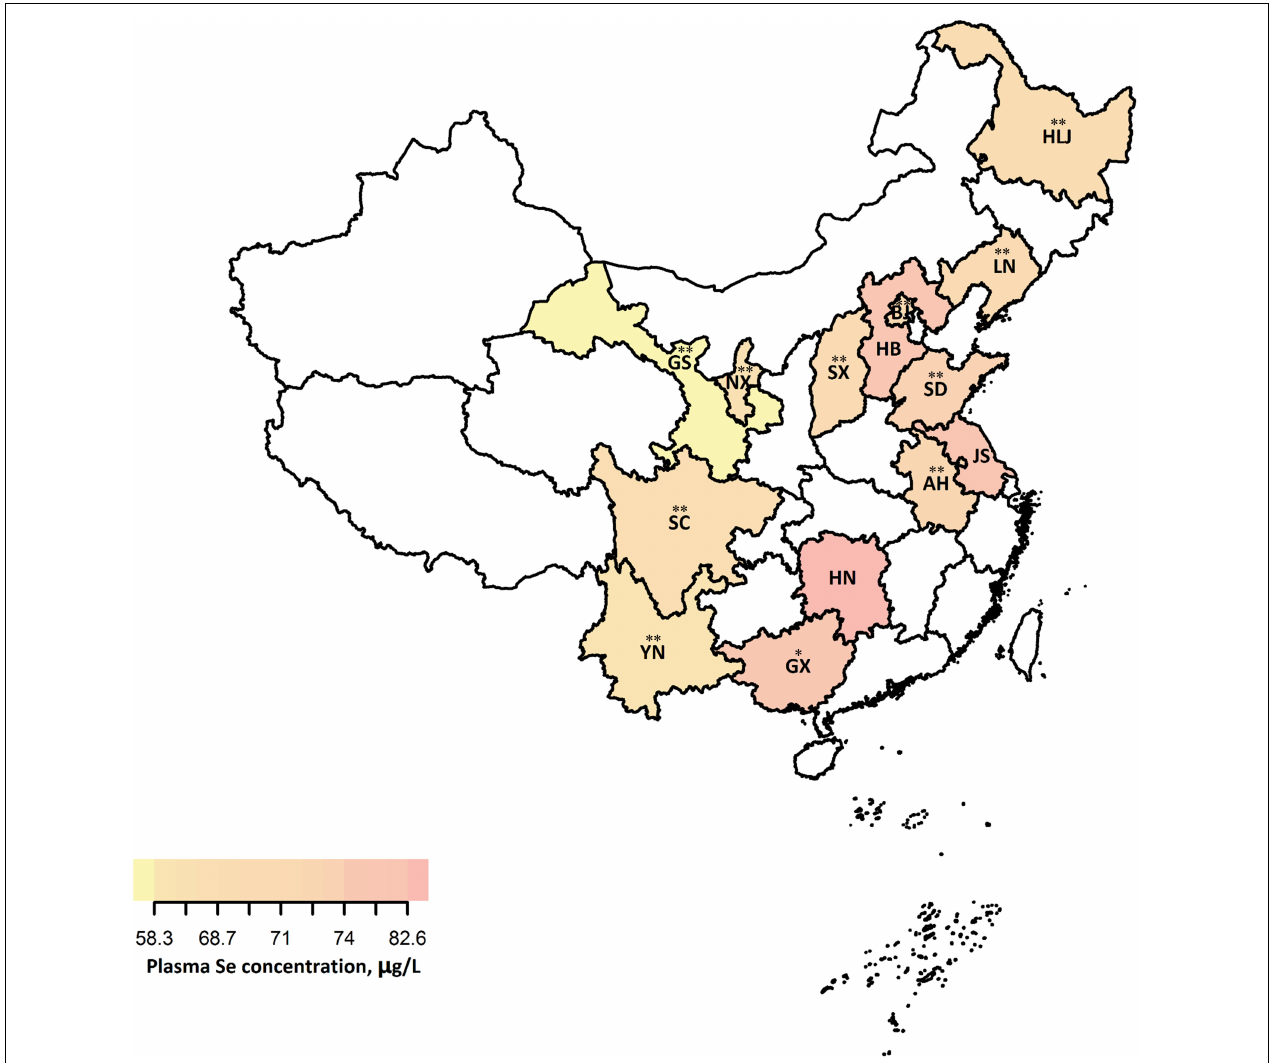
FIGURE 1 | Regional distribution patterns of plasma Se concentrations ( µ g/L) in Chinese middle-aged and elderly adults with hypertension 1 . 1 Plasma Se concentrations were adjusted for sex, age, BMI, SBP, DBP, history of hypertension, antihypertensive drug use, multivitamin use, smoking, alcohol drinking, meat consumption, and consumption of fruits and vegetables. ∗ p < 0.05, ∗∗ p < 0.001, the average plasma Se concentration of this province significantly differed from that of the province with the relatively highest plasma Se status (Hunan, 88.6 µ g/L). The 14 provinces in our study including AH, Anhui ( n = 127); BJ, Beijing ( n = 197); GC, Gansu ( n = 185); GX, Guangxi ( n = 200); HB, Hebei ( n = 200); HLJ, Heilongjiang ( n = 179); HN, Hunan ( n = 200); JS, Jiangsu ( n = 200); LN, Liaoning ( n = 200); NX, Ningxia ( n = 182); SC, Sichuan ( n = 200); SD, Shandong ( n = 172); SX, Shanxi ( n = 196); and YN, Yunnan ( n =